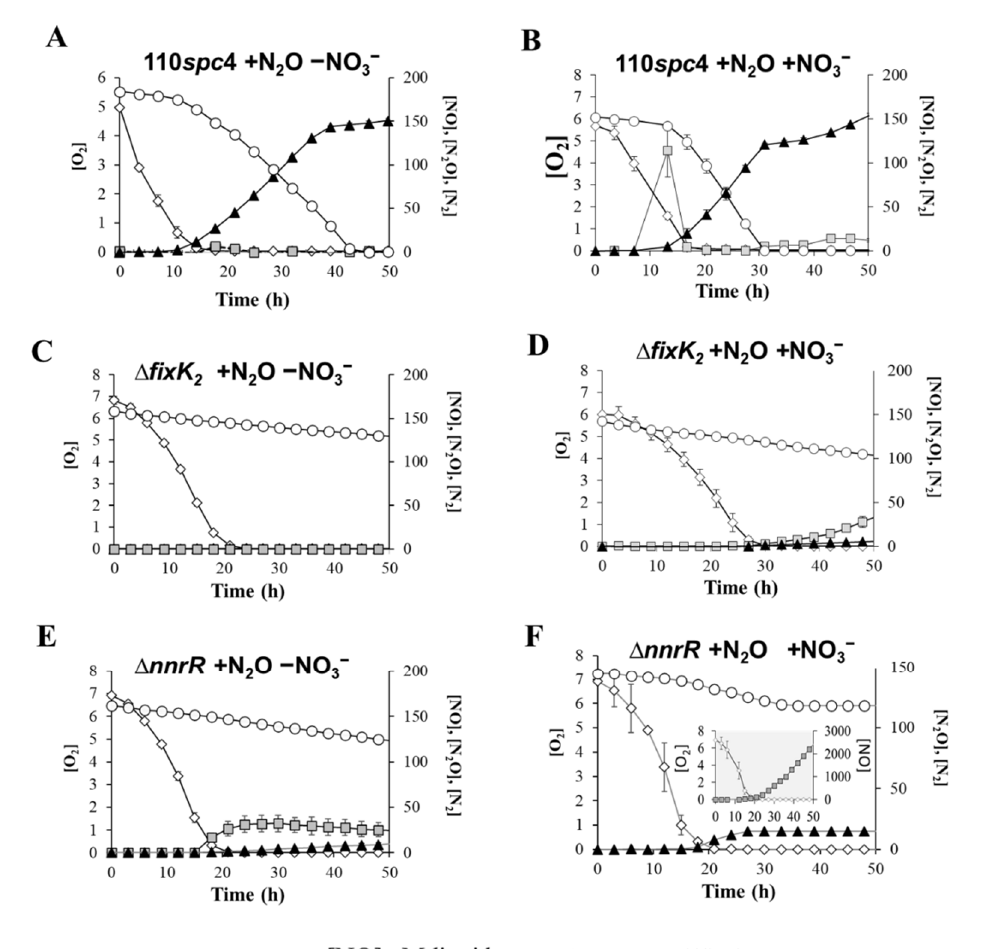
Figure 3. Impact of FixK 2 and NnrR inactivation on N 2 O consumption. Measurement of O 2 and N 2 O respiration and concentrations of NO and N 2 . B. diazoefficiens 110 spc 4 parental strain ( A , B ) and fixK 2 ( C , D ) and nnrR ( E , F ) mutant strains were incubated in vials containing 0.5% O 2 and 5% N 2 O as oxic respiratory and anoxic respiratory substrates, respectively. In addition, a second set of vials were also supplemented with 10 mM NO 3 − ( B , D , F ) as anoxic respiratory substrate. The gradual decline in N 2 O concentration in ( C , D , E ) corresponds to dilution of headspace gases due to sampling. Data are the means and standard deviations of at least three different cultures. Table 2. Summary of growth parameters from N 2 O consumption in the B. diazoefficiens 110 spc 4 pa- rental and fixK 2 and nnrR mutant strains ( A ) and other parameters observed through the incuba- tions, depending on the presence or absence of NO 3 − ( B ). A Anoxic N 2 O Respiration − NO 3 −